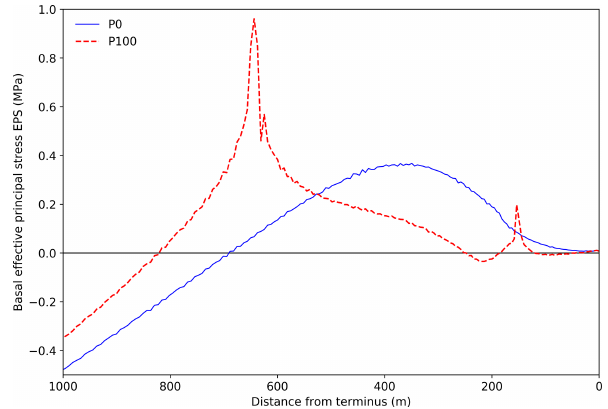
Figure 10. Comparison of basal stresses using the Coulomb sliding law with partial hydraulic connectivity at the ice–bed interface, be- fore (P0) and after (P100) cutting of a 100m notch. Ungrounding occurred between approximately 160 and 640m for P100 and not at all for